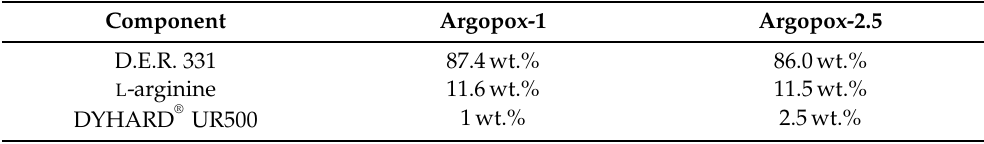
Table 1. Composition of Argopox-1 and